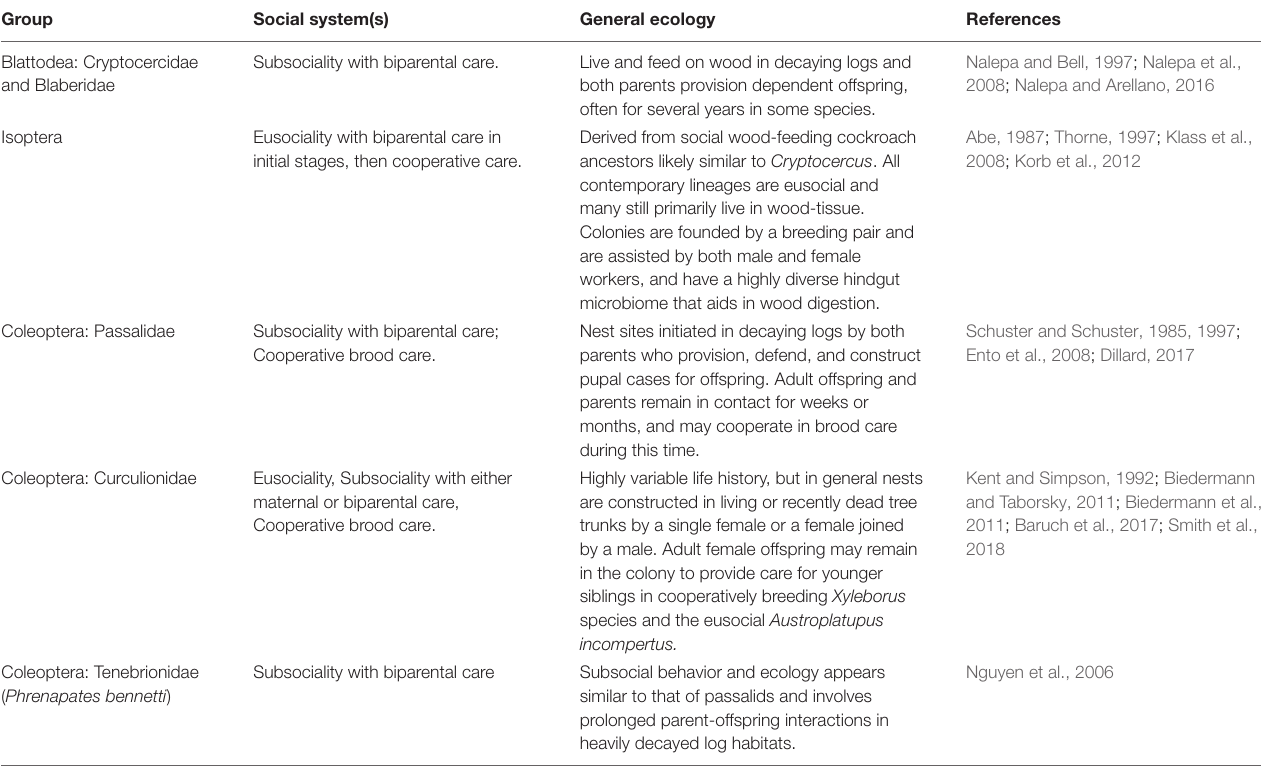
TABLE 1 | Summary of the ecology and life history of the social and gregarious wood-dwelling insects. Group Social system(s) General